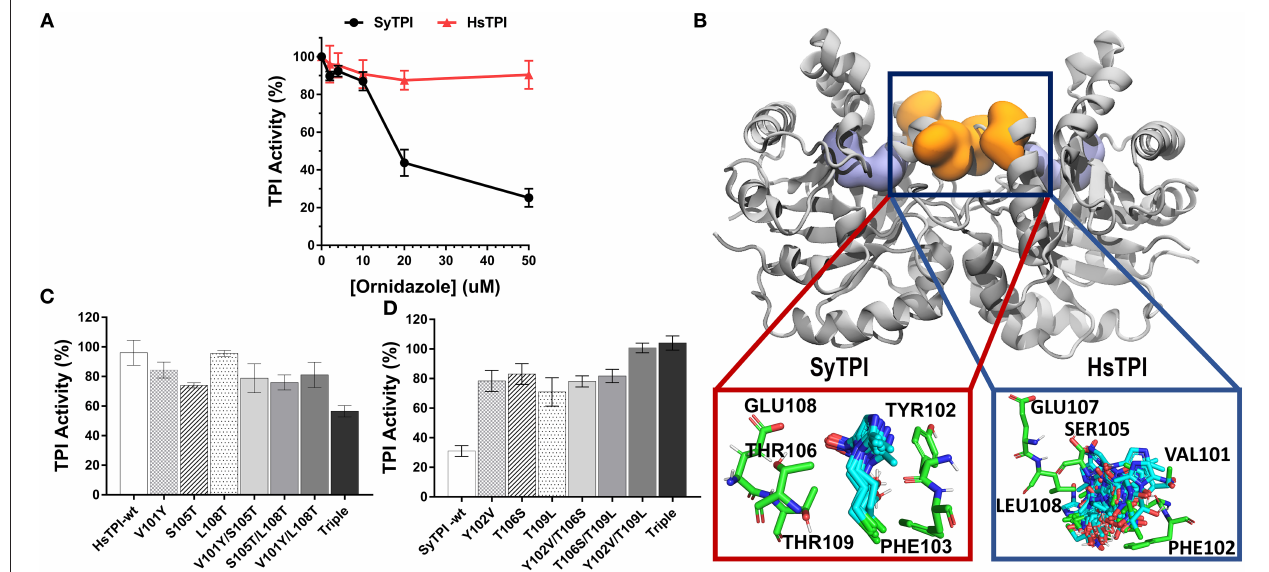
FIGURE 6 | Structural mechanism for selective inhibition of SyTPI by ordinazole. (A) Residual TPI enzymatic activity of SyTPI (black) in comparison to HsTPI (red). TPI enzymatic activity was measured using increasing concentration of ornidazole from 0 to 50 µ M followed by an incubation period of 60min at 21 ◦ C. Results are expressed as mean percentage of the activity with respect to the untreated protein sample. Each experiment was performed by triplicate. (B) Localization of the ornidazole-binding site identified by ensemble docking simulations. The binding site for ornidazole is located at the interface of TPI in both SyTPI and HsTPI. In SyTPI, ornidazole adopts a consensus orientation in the interface and establish stable and specific contacts with the residues in this site (red box). Conversely, no specific ligand-protein contacts are found in the ornidazole-HsTPI complexes, leading to a highly heterogeneous spatial orientations of the inhibitor at the interface site of HsTPI (blue box). TPI is shown as gray ribbons and the ornidazole-binding site as orange surface. For reference, the location of the catalytic sites is shown as a violet surface representation. SyTPI and HsTPI residues as well as ornidazole are shown as sticks. (C) A few residues are responsible for the inhibitory effect of ornidazole in HsTPI. Relative triosephosphate activity for single, double and triple mutants that mimic the ornidazole binding site of SyTPI in HsTPI. (D) An inhibitory effect of ornidazole in SyTPI can be eliminated by site-directed mutagenesis. Relative triosephosphate activity for single, double and triple mutants that substitute the SyTPI ornidazole binding site by the corresponding residues present in